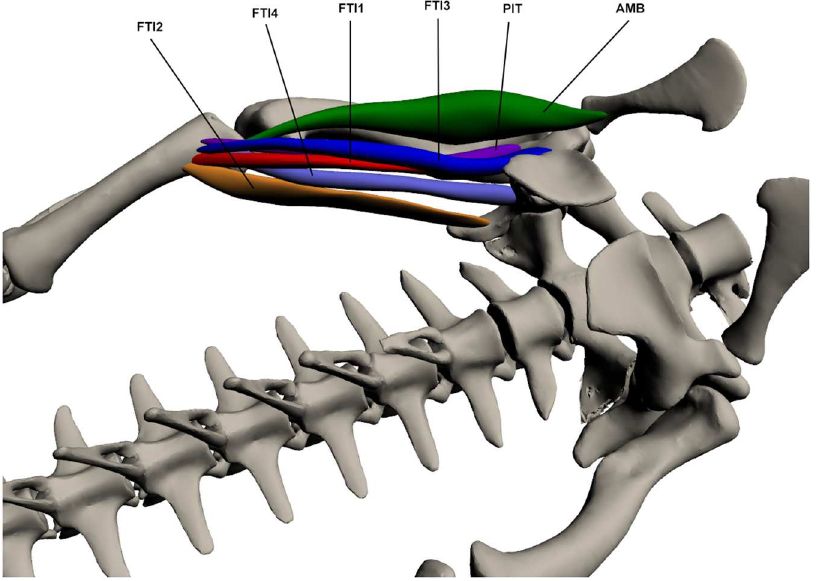
Fig 14. Superficial ventral muscles of the upper hindlimb. AMB: Ambiens , PIT: Pubo-ischio-tibialis ,FTI1- 3: Flexor tibialis internus1–3